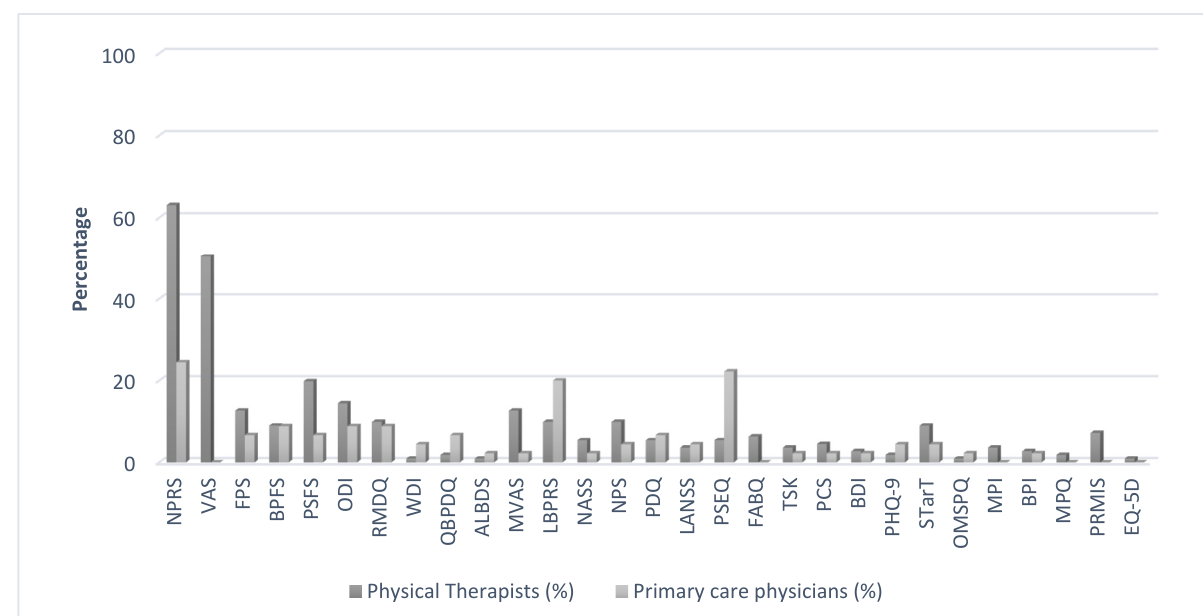
Figure 1. Patient-reported outcome measures used by the primary care physician and physical therapist participants. NPRS: Numeric Pain Rating Scale, VAS: Visual Analogue Scale, FPS: Faces Pain Scale, BPFS: The Back Pain Functional Scale, PSFS: Patient-Specific Functional Scale, ODI: Oswestry Disability Index, RMDQ: Roland–Morris Disability Questionnaire, NASS: The NASS Lumbar Spine Outcome Assessment Instrument, WDI: The Waddell Disability Index, QBPDQ: The Quebec Back Pain Disability Scale, ALBDS: The Aberdeen Low Back Disability Scale, MVAS: The Million Visual Analogue Scale, LBPRS: The Low Back Pain Rating Scale, NPS: The Neuropathic Pain Scale, PDQ: Pain Detect Questionnaire, LANSS: Leeds Assessment of Neuropathic Symptoms and Signs, PSEQ: The Pain Self-Efficacy Questionnaire, FABQ: The Fear-Avoidance Belief Questionnaire, TSK: The Tampa Scale of Kinesiophobia, PCS: The Pain Catastrophizing Scale, BDI: The Beck Depression Inventory, PHQ-9: The 9-Item Patient Health Questionnaire, MPI: Multidimensional Pain Inventory, BPI: The Brief Pain Inventory, MPQ: The McGill Pain Questionnaire, START: STarT Back Screening Tool, OMSPQ: Örebro Musculoskeletal Pain Screening Questionnaire, PRMIS: Patient-Reported Outcomes Measurement Information System, EQ-5D: EuroQol Five Dimensions. Table 2. Number of outcome measures used in clinical practice by the 111 primary care physicians and 45 physical therapist participants.